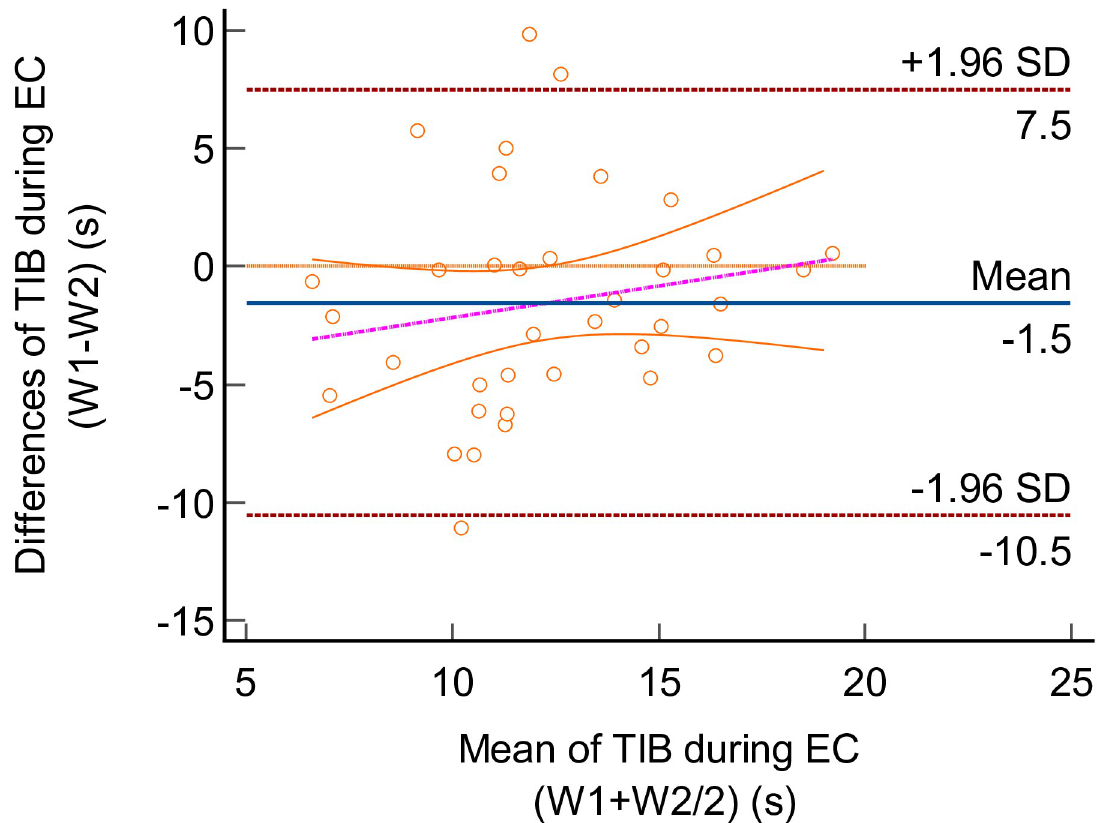
Fig 3. Bland-Altman plot for the time in balance (TIB) of the single leg (SL) stance task in eyes-closed (EC) condition. The differences between Week 1 (W1) and Week 2 (W2) were plotted against the mean of W1 and W2. The solid line (blue) indicated the mean difference (bias). The interval between upper and lower limits represented the 95% Limit of Agreement (LoA).